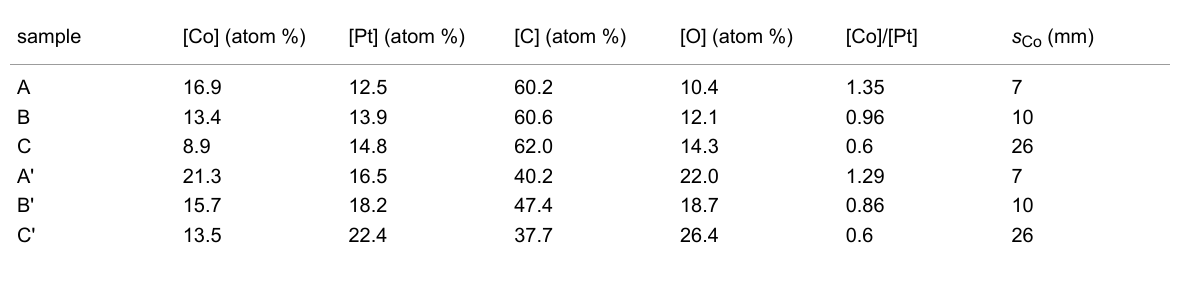
Table 2: Sample composition and Co 2 (CO) 8 injector distance s Co for Co–Pt samples. Samples A, B and C are as-grown. Samples A', B' and C' are subject to a post-growth electron-irradiated treatment with doses of 10.58, 7.02 and 14.24 μ C/ μ m 2 , respectively. For all depositions the Me 3 Pt(IV)CpMe injector’s capillary distance to the substrate surface at the focus of the electron beam was kept constant at s Pt = 32 mm. Table data reproduced from [33].